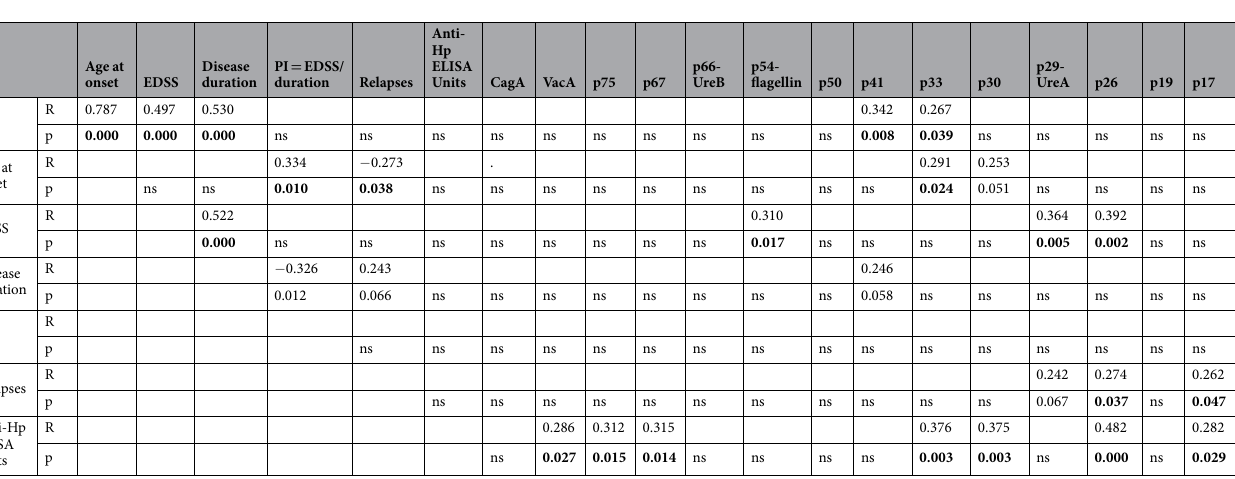
Table 4. Clinical correlations of anti-Hp antibody reactivity to individual antigens and features of multiple sclerosis. R represents Pearson correlation coefficient. p represents p value (2 tailed) associated with the correlation. p -values < 0.05 are shown in bold; p -values with a statistical tendency ( < 0.1) are also shown. Abbreviations: CagA, protein from cytotoxin-associated gene A; EDSS, extended disability status scale;